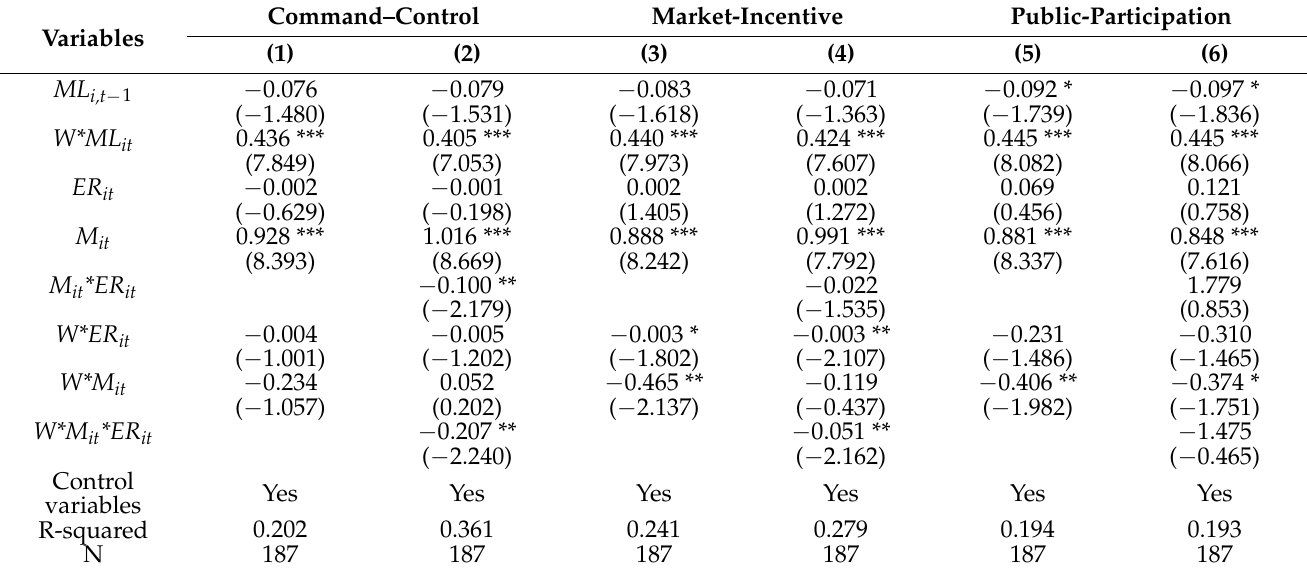
Table 9. The moderating results of efficiency change in the eastern